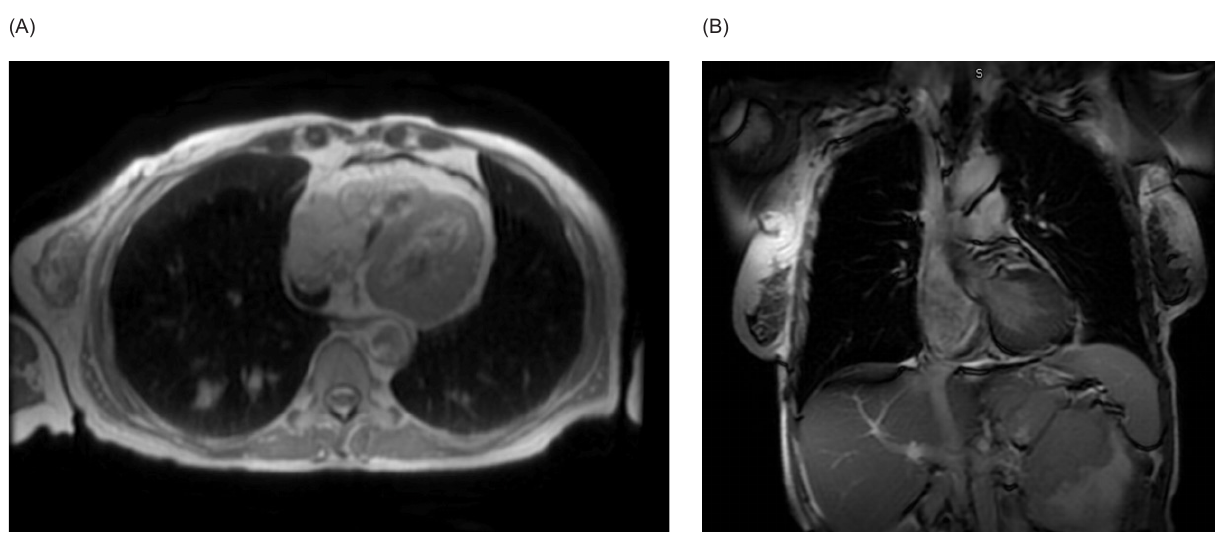
Figure 3: Cardiac MRI. (A) Transverse and (B) coronal views demonstrating a large intra-cardiac tumor occupying the majority of the right atrium extending through the myocardium into the epicardial space and through the tricuspid valve into the right